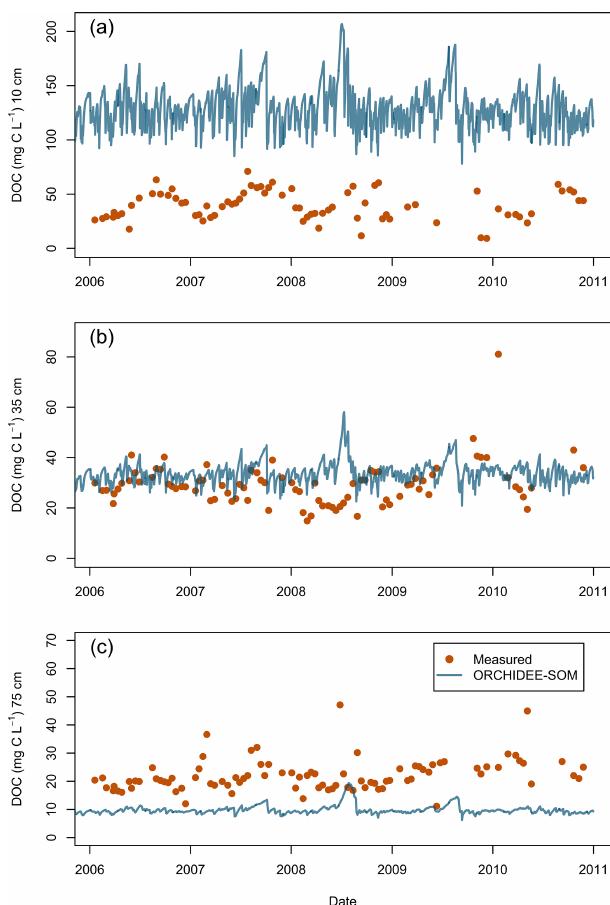
Figure 4. ORCHIDEE-SOM simulated (daily values) and measured DOC dynamics at Brasschaat forest at three soil depths: (a) 10cm, (b) 35cm, and (c) 75cm. Error bars are not displayed due to data